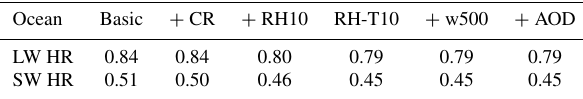
Table 2. MAE (K per day) for the prediction of LW or SW heating rates of clouds over ocean, from experiments